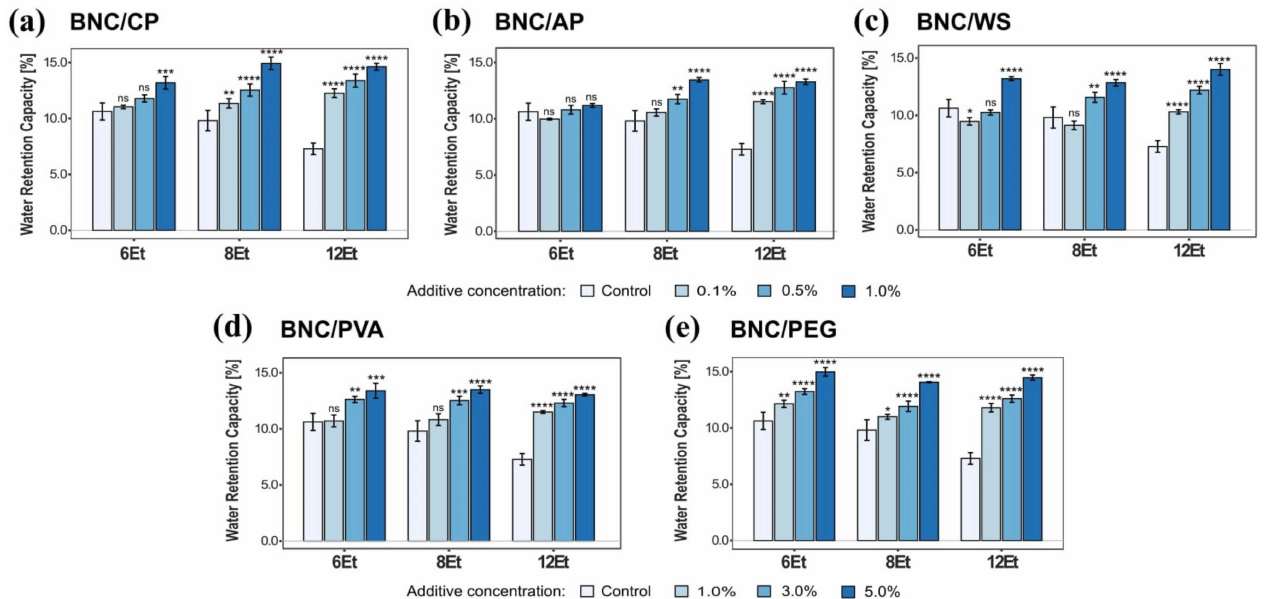
Figure 9. Water retention capacity of bacterial cellulose composites produced by K. hansenii H3 (6Et), K. rhaeticus K4 (8Et), and the strain isolated from balsamic vinegar (12Et). ( a ) BNC/CP, ( b ) BNC/AP, ( c ) BNC/WS, ( d ) BNC/PVA, and ( e ) BNC/PEG. Statistically significant differences were calculated us- ing a one-way ANOVA with Tukey’s multiple comparison post-hoc test and are shown as * = p ≤ 0.05, ** = p ≤ 0.01, *** = p ≤ 0.001, and **** = p ≤ 0.0001, compared to control (native)